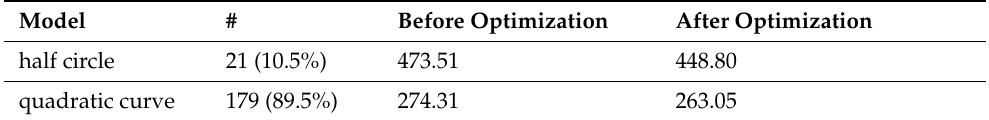
Table 5. Parameter optimization